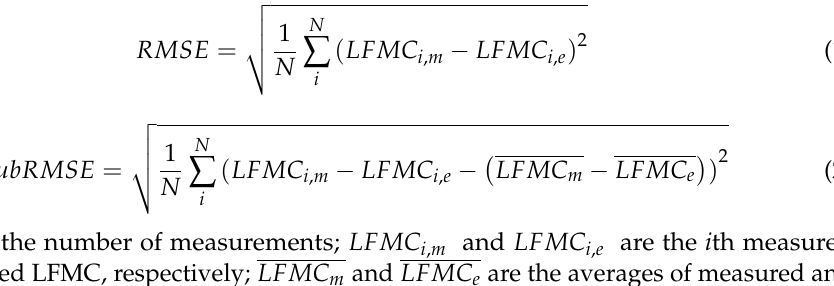
Table 3. Evaluation results of LFMC retrieval results based on LSTM, TCN and TCN-LSTM.